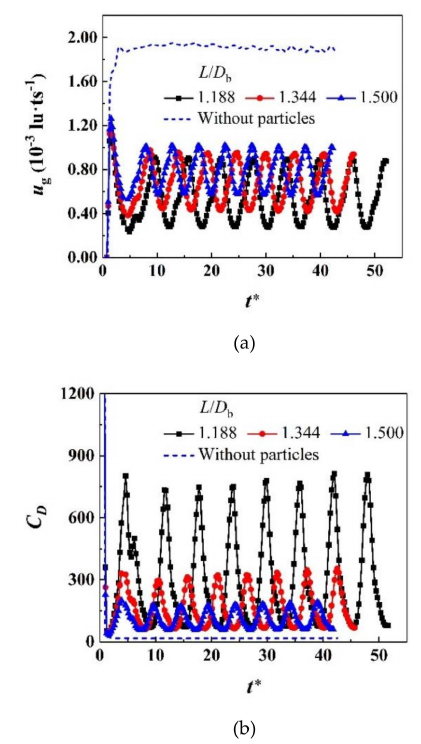
Figure 7. Variations of u g ( a ) and C D ( b ) with dimensionless time at Re Gr = 100 and Eo = 20.